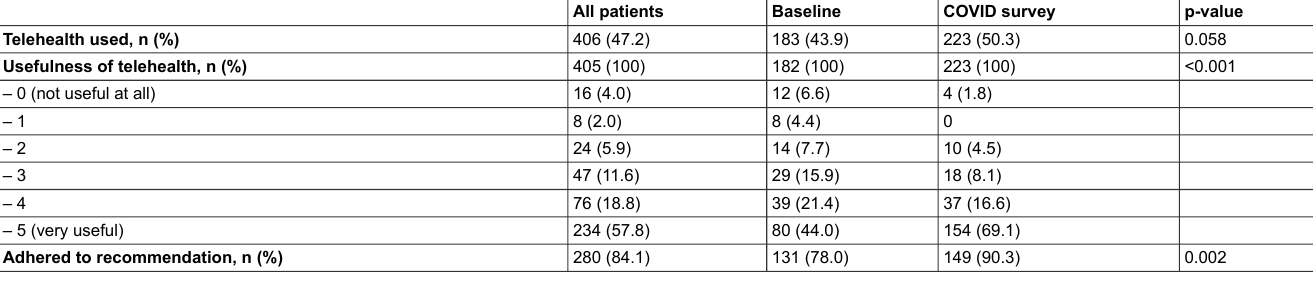
Table 4: Comparison of baseline and COVID survey data. Usefulness of telehealth n = 405, Adherence to recommendation n = 333 For this table, data from the published baseline sur- vey were included.